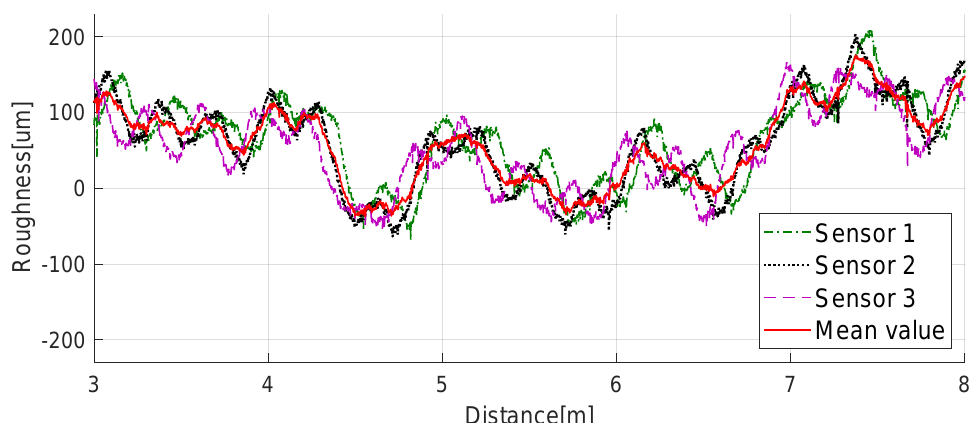
Figure 15. Longitudinal railhead roughness of Track A.